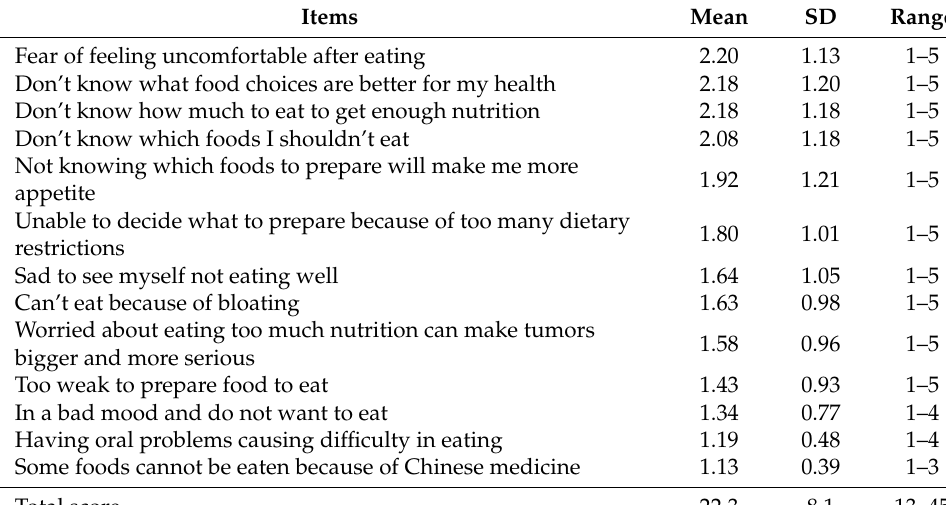
Table A1. Participants’ diet preparation difficulties (N =